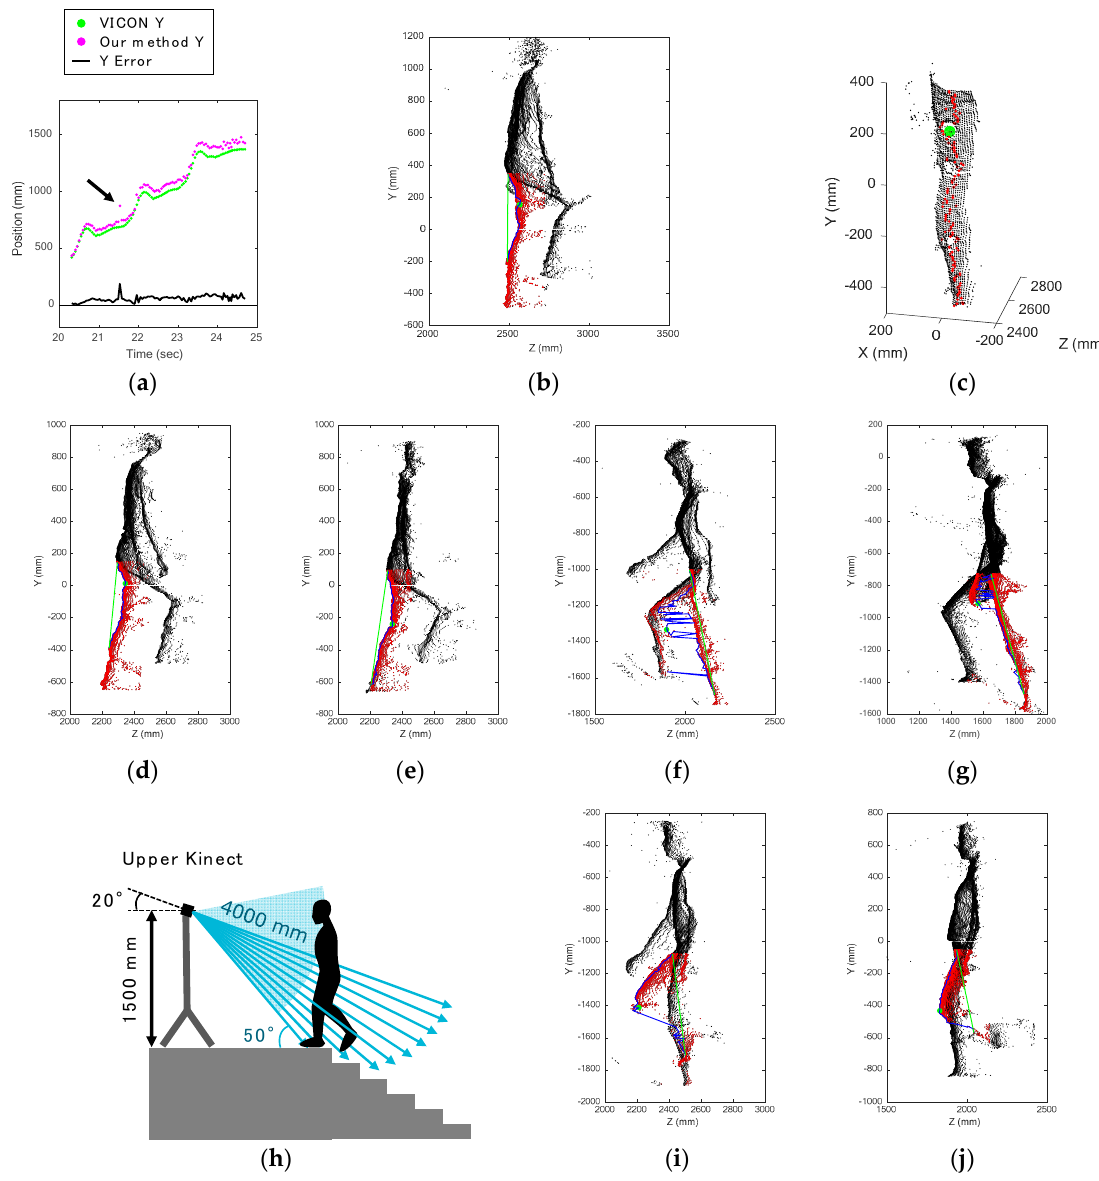
Figure 12. ( a ) Subject 8’s knee displacement on Y axis during third stair ascent (abnormal data indicated by an arrow); ( b ) estimated knee joint position (green dot) that was misrecognized and leg area (red dots); ( c ) a data hole made by a reflective marker on the thigh was falsely recognized as the knee joint position; ( d ) instance in which the boundary of the gluteus maximus and thigh was falsely recognized during ascent captured from the back in a male subject; ( e ) comparison of Figure 10d: the same situation of a female subject; ( f ) error caused by confusion of left and right leg data; ( g ) error caused by noise due to hands; ( h ) location giving the lowest density of plots of the shins in the case of the upper Kinect; ( i ) example of low-density plots of the shins during ascent captured by the upper Kinect; ( j ) example of low-density plots of the shins during descent captured by the lower Kinect.